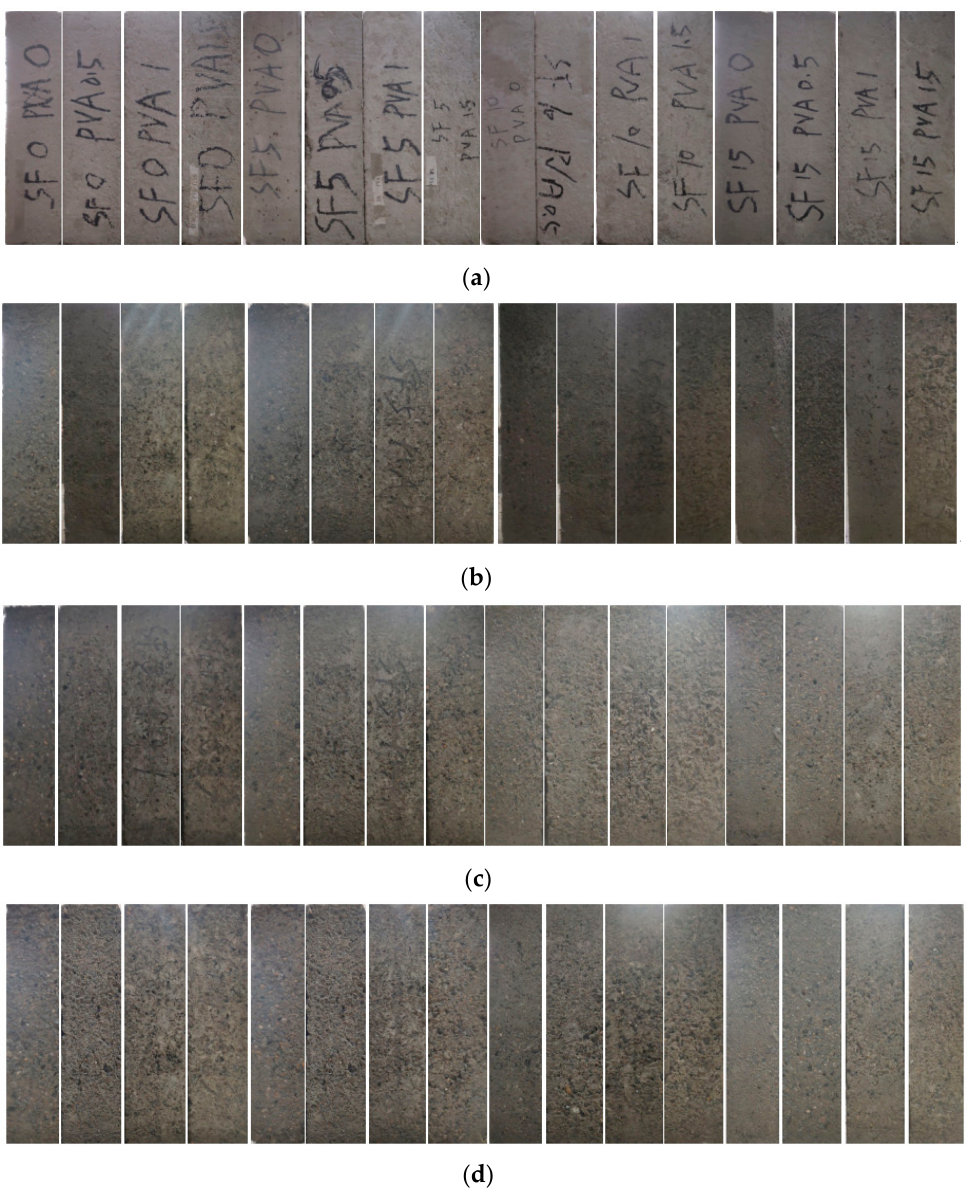
Figure 6. Apparent changes in freeze-thaw cycles: ( a ) Freeze-thaw cycle 0 times, ( b ) Freeze-thaw cycle 50 times, ( c ) Freeze-thaw cycle 100 times, and ( d ) Freeze-thaw cycle 150 times.